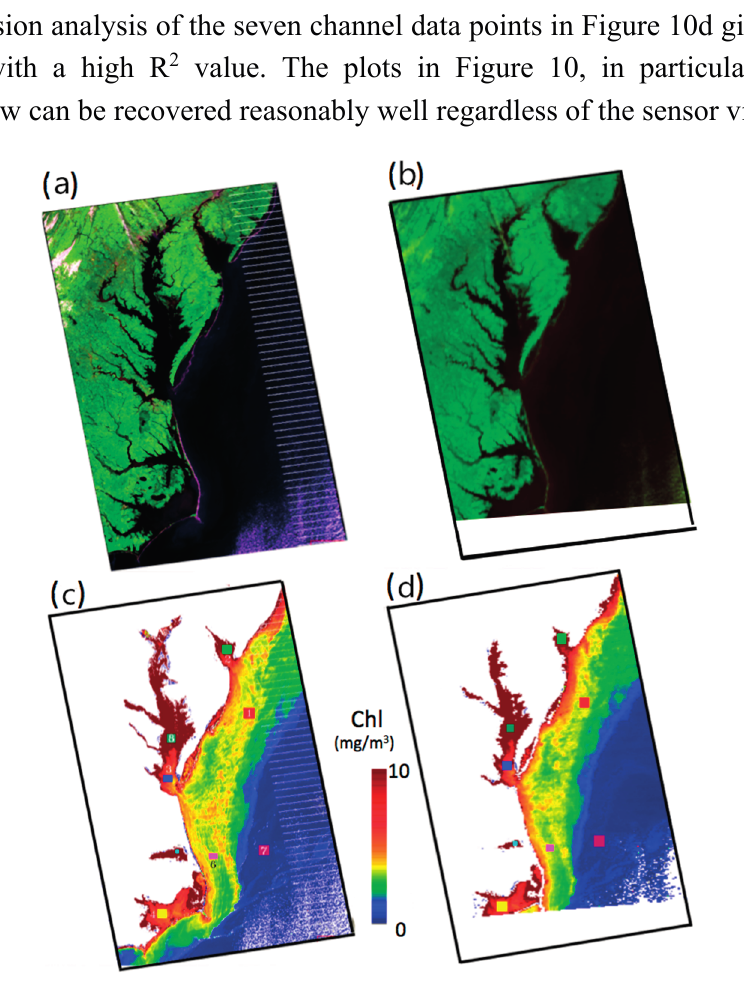
Figure 9. Satellite images over the Chesapeake Bay acquired on 9 March 2013: ( a ) VIIRS RGB image; ( b ) MODIS RGB image; ( c ) VIIRS Chlorophyll concentration; and ( d ) MODIS Chlorophyll